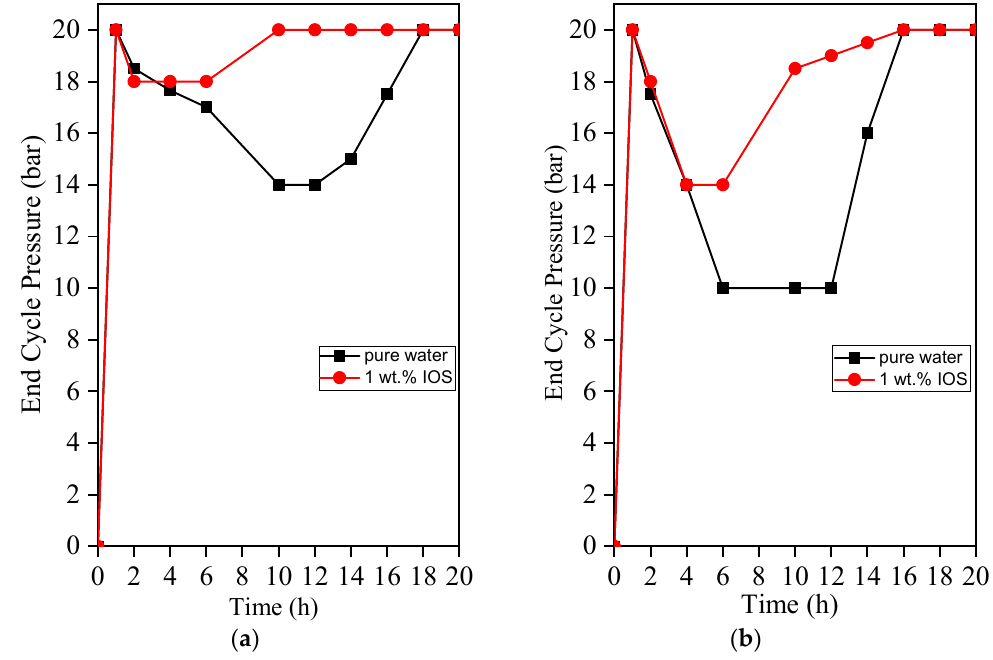
Figure 10. Column pressure at the end of adsorption cycle vs. time for ( a ) BG-2 and ( b ) KH-2 shales. The lowest pressure observed during the test was 10 bar (a 50% change in pressure), and it occurred after about 6 h (3rd cycle). The pressure changes at the end of each subsequent cycle became gradually smaller until the last three cycles in which there was no change in pressure indicating that complete CH 4 adsorption was achieved. In the case of KH-2 that was treated with IOS, the end of cycle pressure profile significantly changed. The lowest pressure observed during the test was 14 bar (a 30% change in pressure), and it occurred after only the third cycle. The pressures at the end of 4th cycles were similar to the 3rd cycle suggesting no change in the rate of adsorption. The next four cycles saw a gradual reduction of the end of cycle pressure, but there was no change in pressure reduction after the 7th cycle. While comparing the behavior of the two curves, it becomes evident that IOS treatment has reduced the adsorption capacity of KH-2 shale.